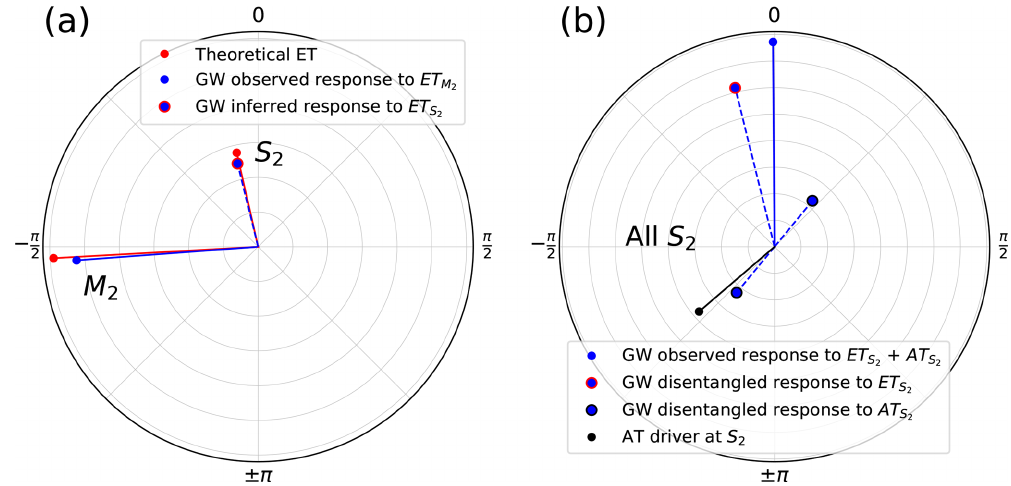
Figure 4. Polar plots showing amplitudes and phases derived from the fitting coefficients using Eqs. (1)–(3). (a) Results of the complex inference of the well response to Earth tides at S 2 from the response at M 2 (Eq. 4). (b) Harmonic disentanglement of the well response to atmospheric tides at S 2 (Eq. 6). In (a) , the Earth tide magnitude is scaled to improve comparison with the groundwater response.